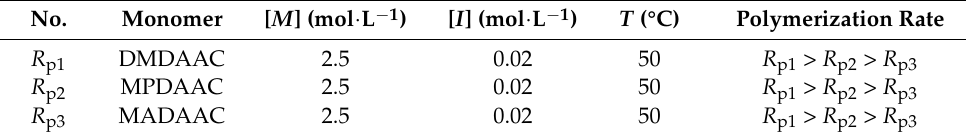
Table 7. Comparison of polymerization rates of different monomers.